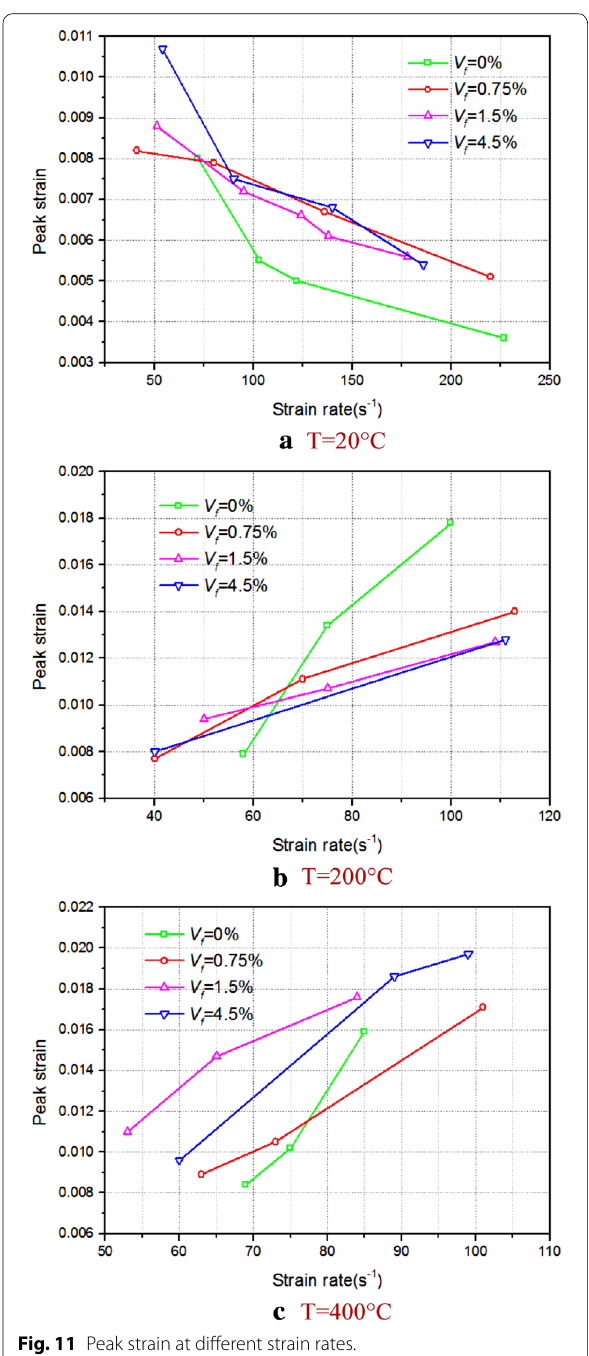
Fig. 11 Peak strain at different strain